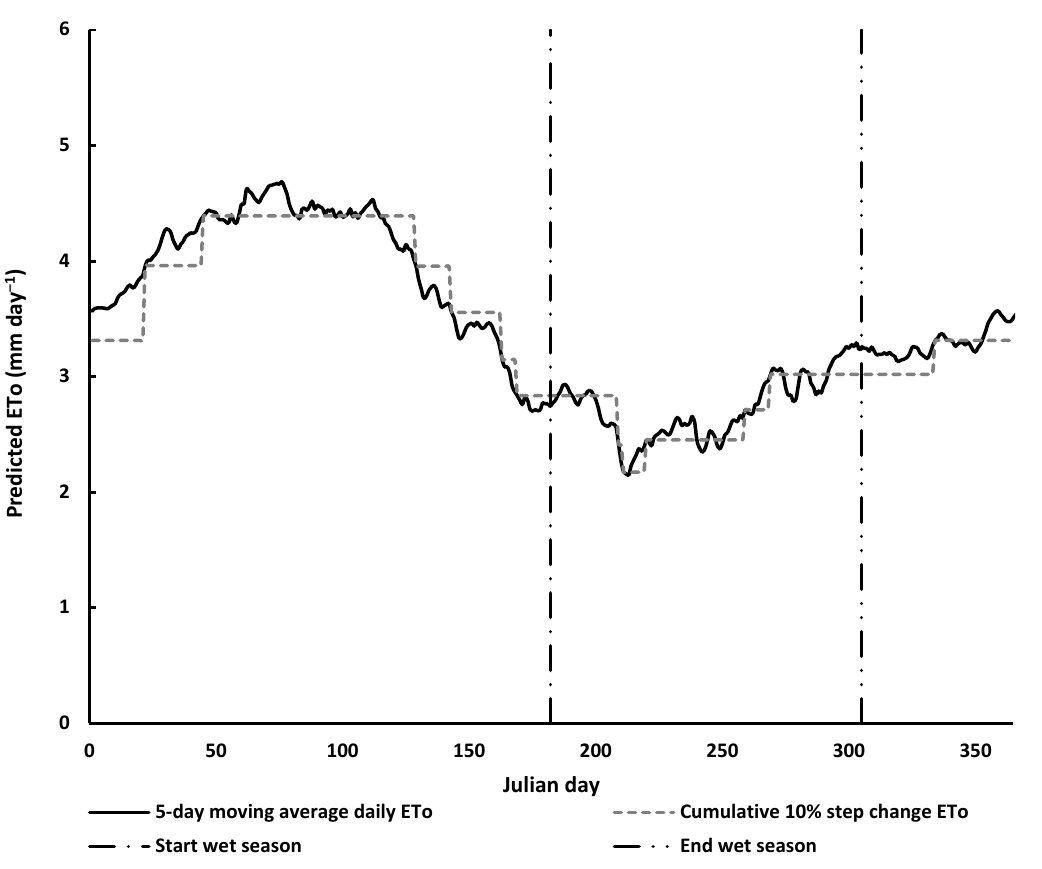
Figure 5. Five ‐ day moving average ET o , and approximate ET o based on absolute cumulative 10% change in ET o for Paksong district, Champasak Province, Laos.